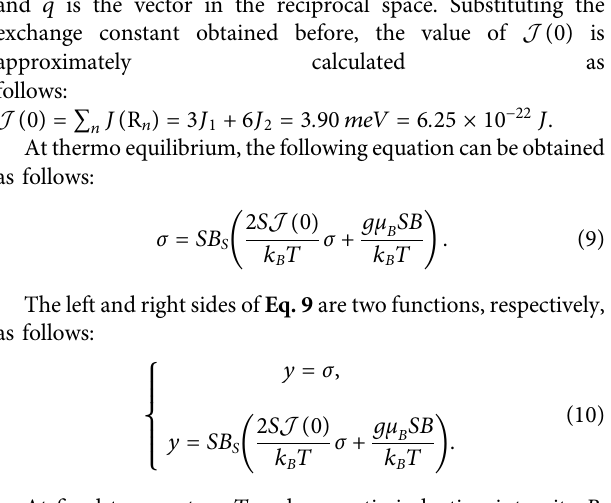
FIGURE 6 | σ − T curves at different values of B